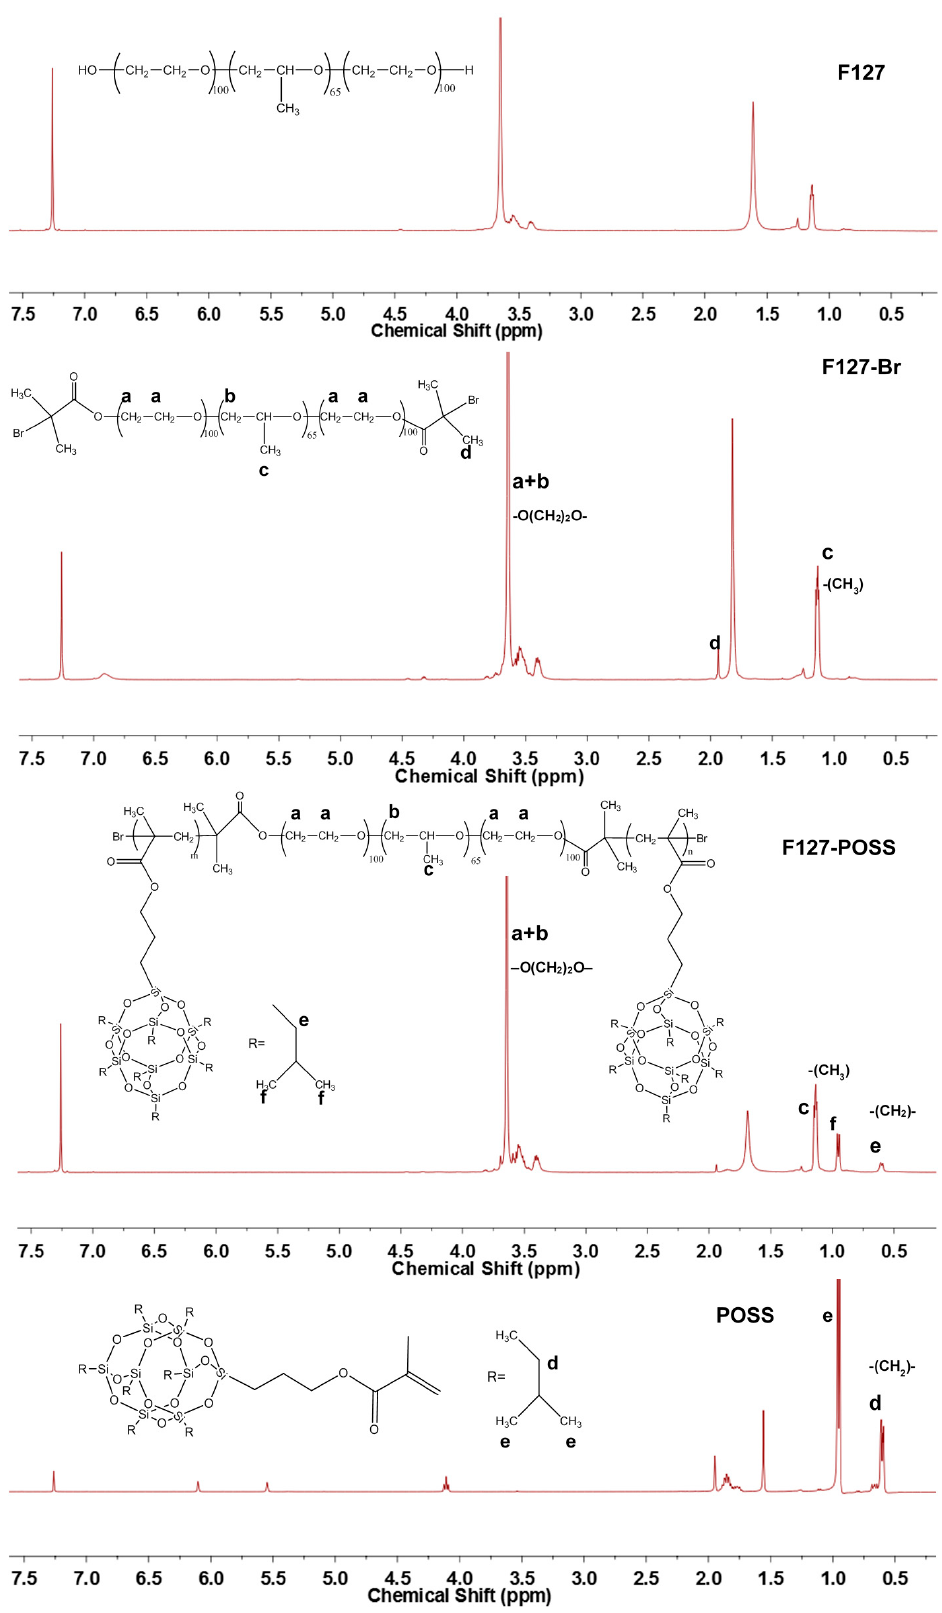
Figure 1. 1 H NMR spectra of F127, F127-Br, F127-POSS, and methacrylisobutyl POSS.